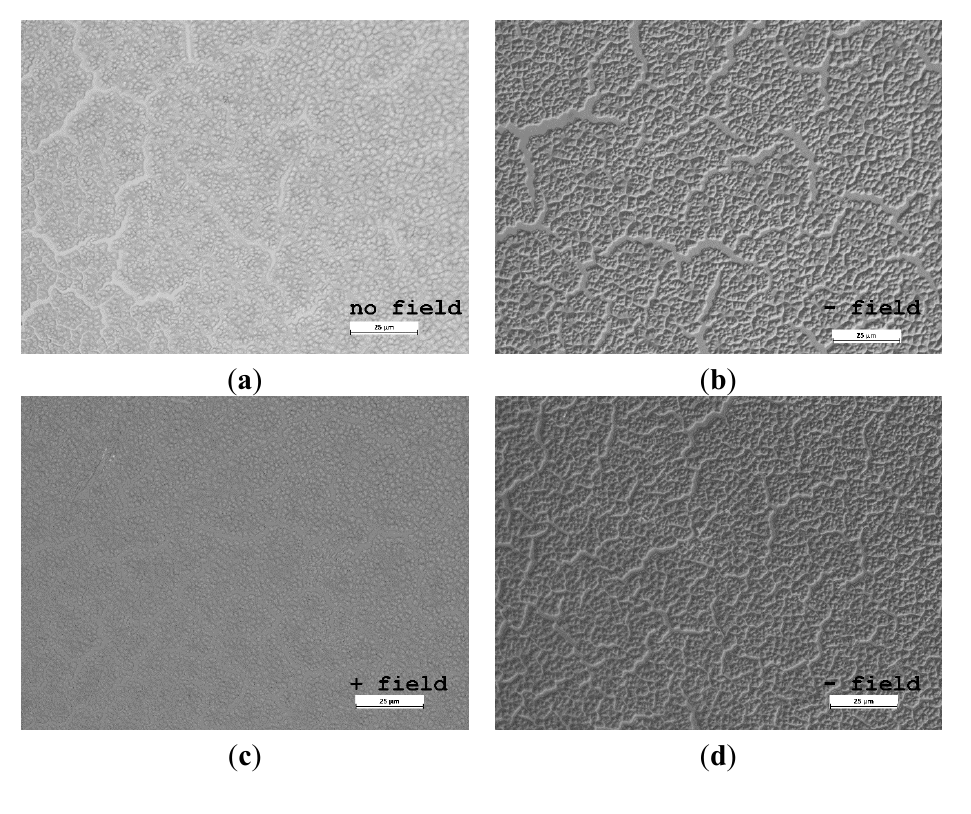
Figure 3. Optical reflected-light microscopy of a P(VDF-TrFE)-coated glass sample after thermal treatment at 140 °C (length of scale bar: 25 µm); ( a ) with no electric field applied; ( b ) whilst negative electric field was applied; ( c ) after further positive electric field was applied; and ( d ) after successive negative electric field was